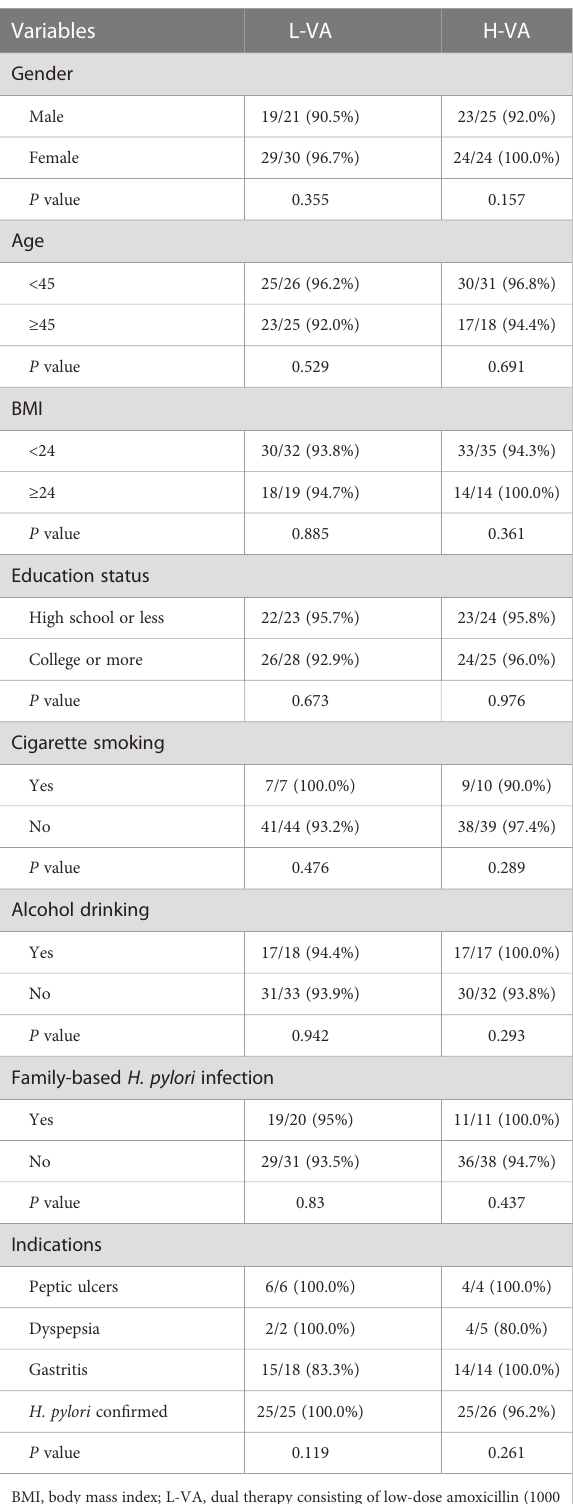
TABLE 4 Factors in fl uencing cure rates in the per-protocol population.